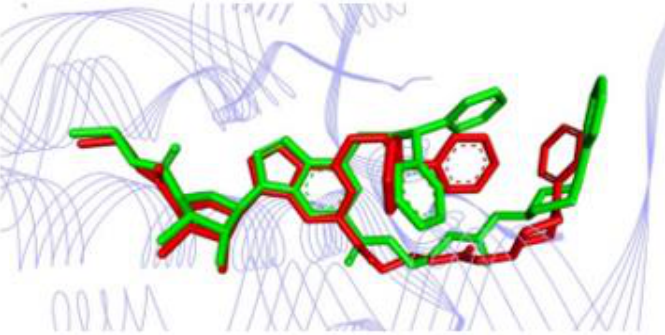
Figure 6. Superposition of the crystallography pose of the ligand (green) with the correspondent theoretical pose (obtained by molecular docking) for the top-ranked compound (red).